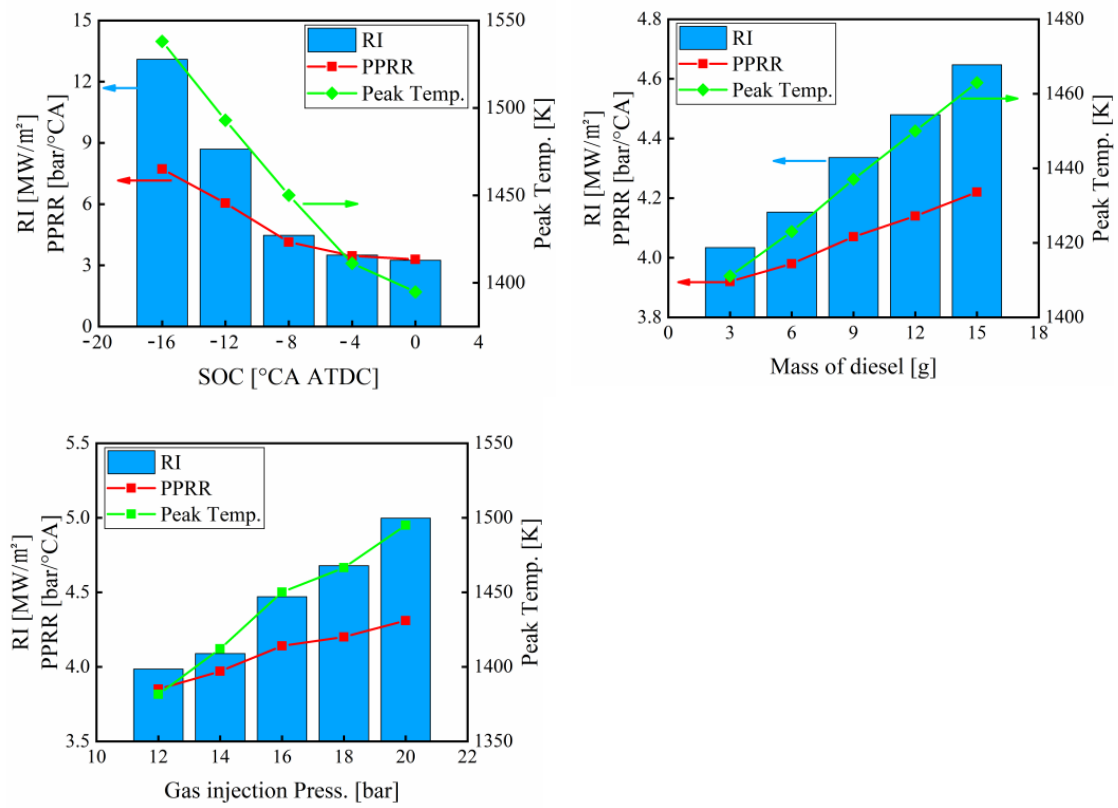
Figure 5. Influence trend of different parameters on combustion.